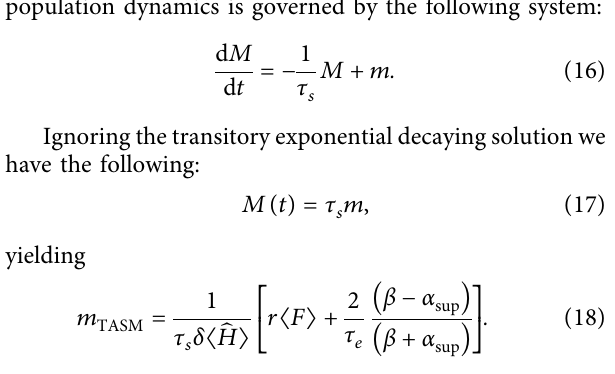
Figure 2: Theoretical and simulated M as a function of β . Our TASM (Flores) theoretical result is represented by thick (dotted) line (for τ s � 5 and α � 0 . 8), thin (dotted) line (for τ s � 0 . 5 and α � 0 . 8), and dashed (dot-dashed) line (for τ s � 5 and α � 2 . 8). Rectangles, triangles, and circles correspond to simulated results for the same choices of parameters τ s and α , respectively. The remaining pa- rameters values are δ � 1 and p � 13.